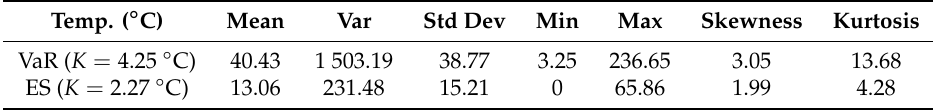
Table A1. Descriptive Statistics for seasonal HDDs for the period of time 1970–2016 and 10% percentile